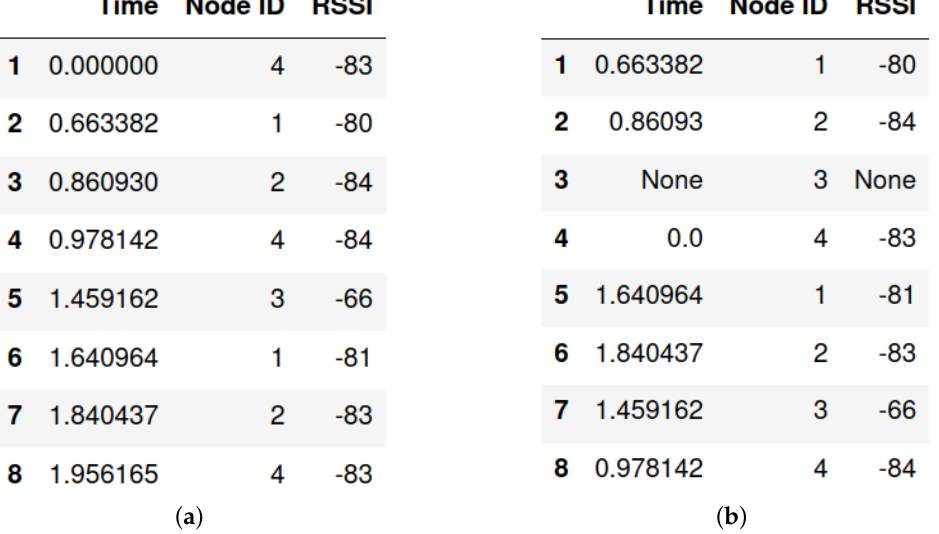
Figure 6. Packets processing. ( a ) Raw packets (before processing); ( b ) Processed chunks of